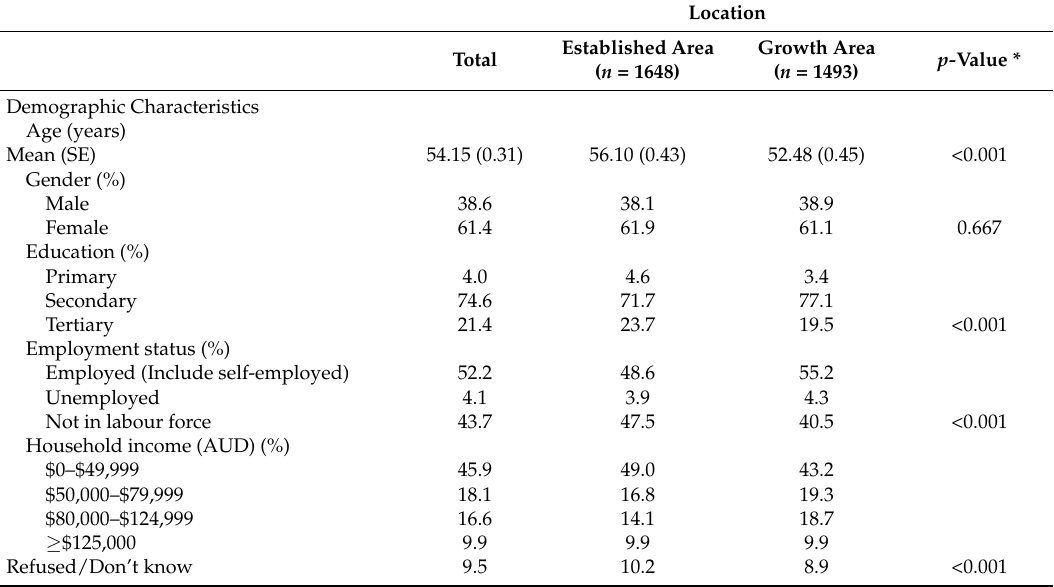
Table 1. Descriptive statistics of the preventive health survey (PHS) respondents by location: established versus urban-growth local government